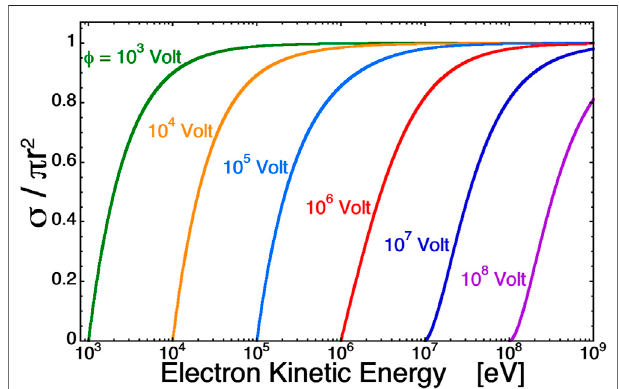
FIGURE 5 | The reduction of collection area of a negatively-charged sphere (vertical axis) as a function of electron kinetic energy (horizontal axis) and as a function of the potential of the sphere (colored curves).